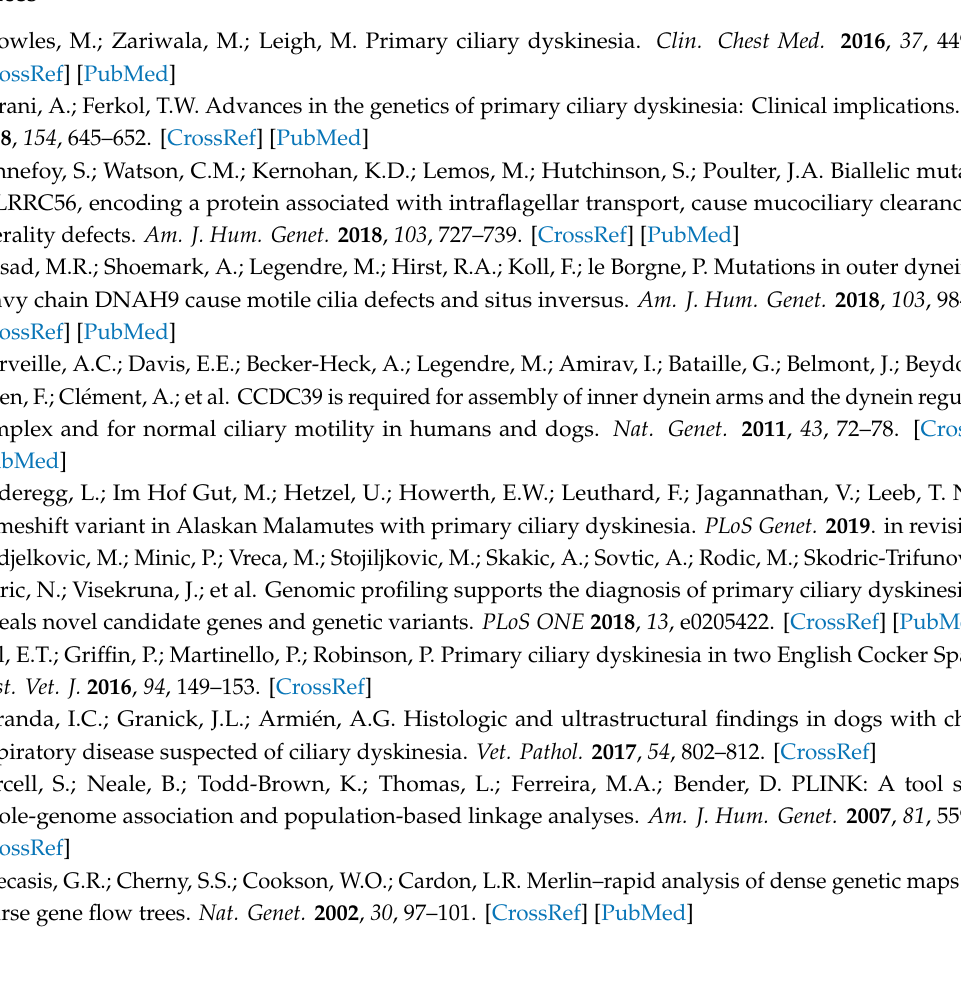
control dogs. Table S2: Linkage and homozygosity mapping, Table S3: Accession numbers of 594 dog and 8 wolf genome sequences, Table S4: Private protein changing variants in the sequenced Rough Collie with recurrent inflammatory pulmonary